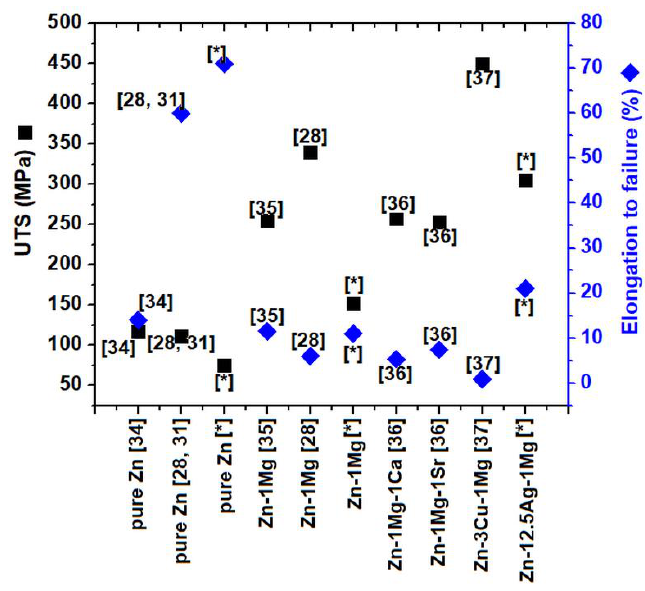
Figure 11. UTS: elongation to failure comparison of the investigated Zn-based alloys.